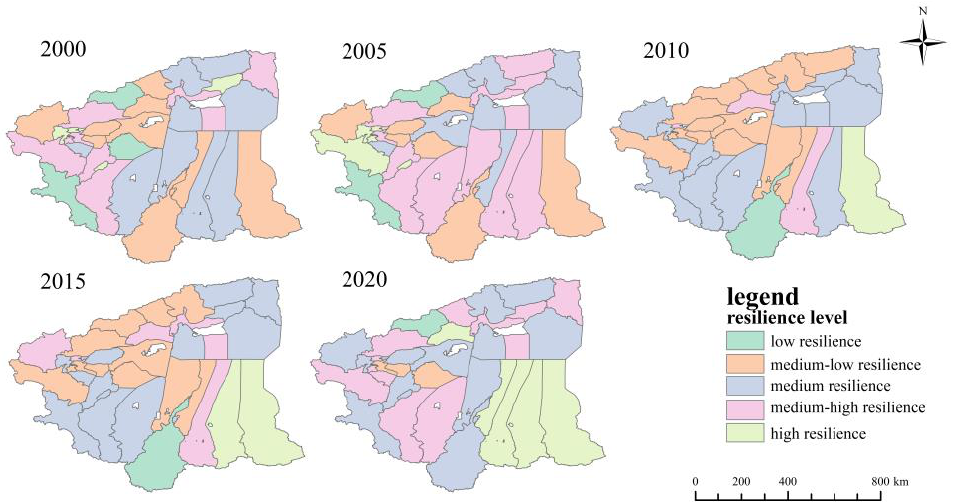
Figure 9. Distribution of morphological resilience level of four prefectures in southern Xinjiang from 2000 to 2020.